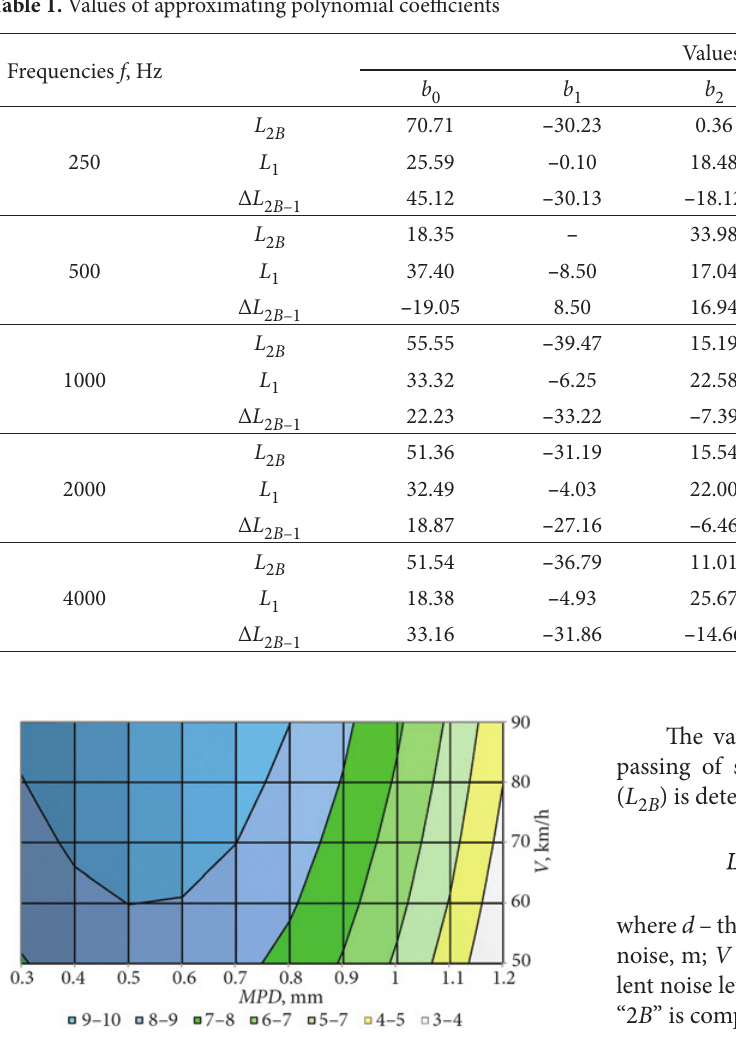
Fig. 8. Influence of pavement macrotexture and speed of vehicle on difference between noise level of heavy vehicle and noise level of passenger car (in dB(A)) Table 2. Values of differences of maximum noise level of statistic heavy vehicle and passenger car in relation to pavement macrotexture (